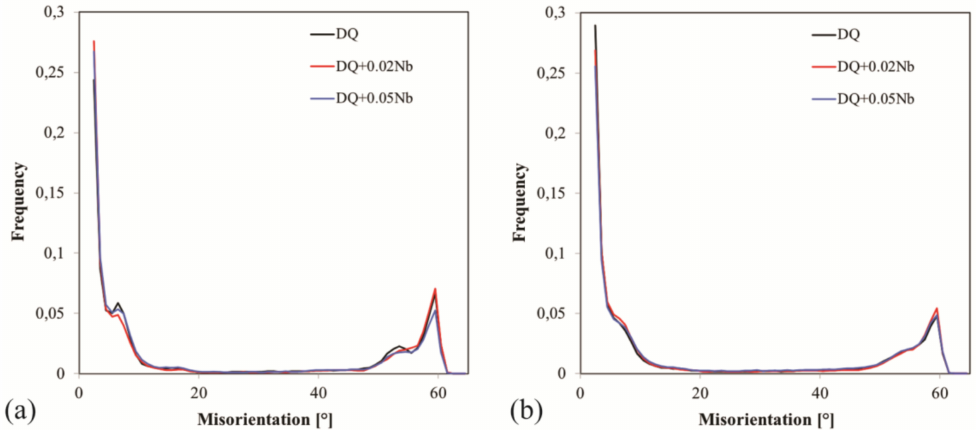
Figure 12. Grain boundary misorientation distributions ( > 2.5 deg) of investigated steels. ( a ) 920 ◦ C, ( b ) 820 ◦